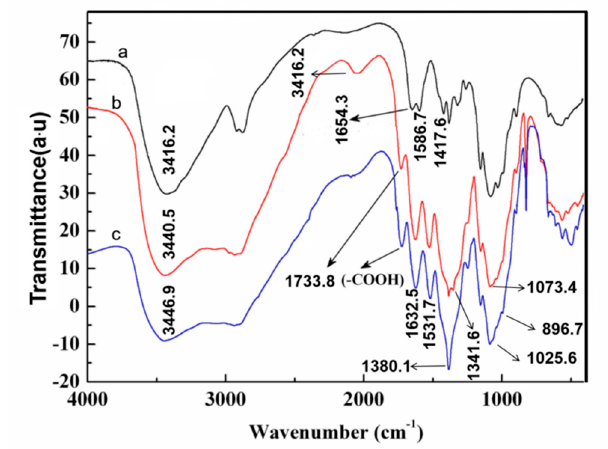
Figure 5. The infrared spectra of original chitosan, oxidized chitosan with different oxidation degree: ( a ) original chitosan; ( b ) oxidized chitosan with 29.4% of DO; ( c ) oxidized chitosan with 55.5% of DO.